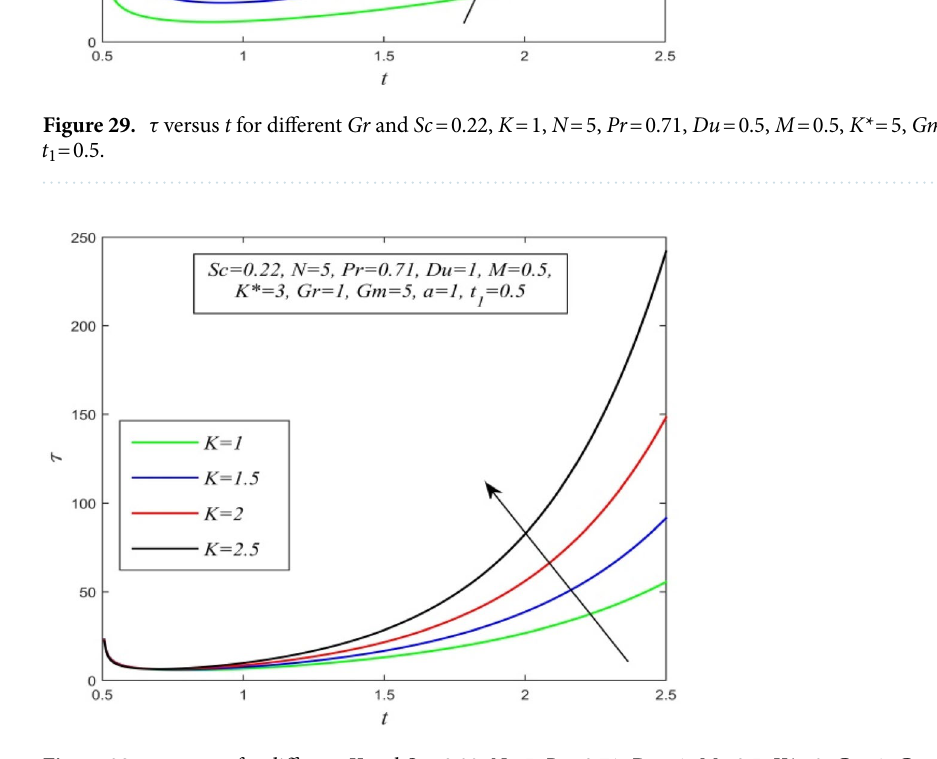
Figure 30. τ versus t for different K and Sc = 0.22, N = 5, Pr = 0.71, Du = 1, M = 0.5, K* = 3, Gr = 1, Gm = 5, a = 1, t 1 =